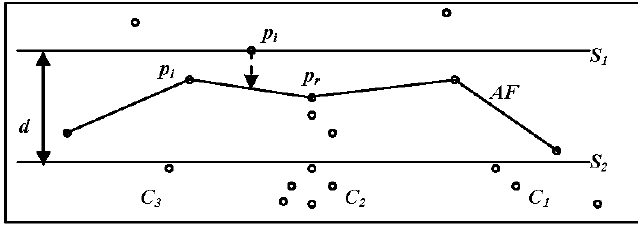
Figure 2. Sweeping the points by the sweep-lines.